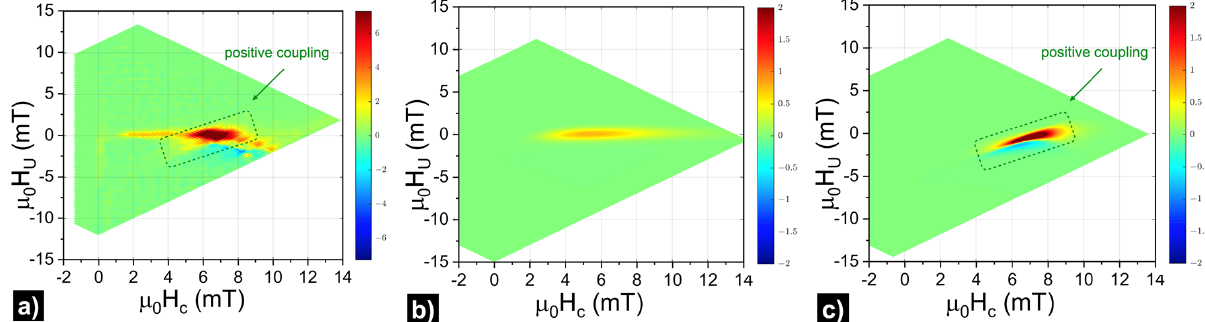
Figure 3. ( a ) The experimentally obtained FORC diagram and simulated FORC diagrams for ( b ) non-interacting and ( c ) positively coupled magnetic